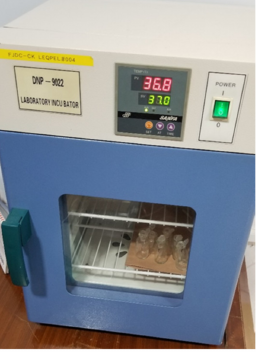
Figure 3. Incubator for drying of Eppendorf tubes (Sanfa DNP-9022).